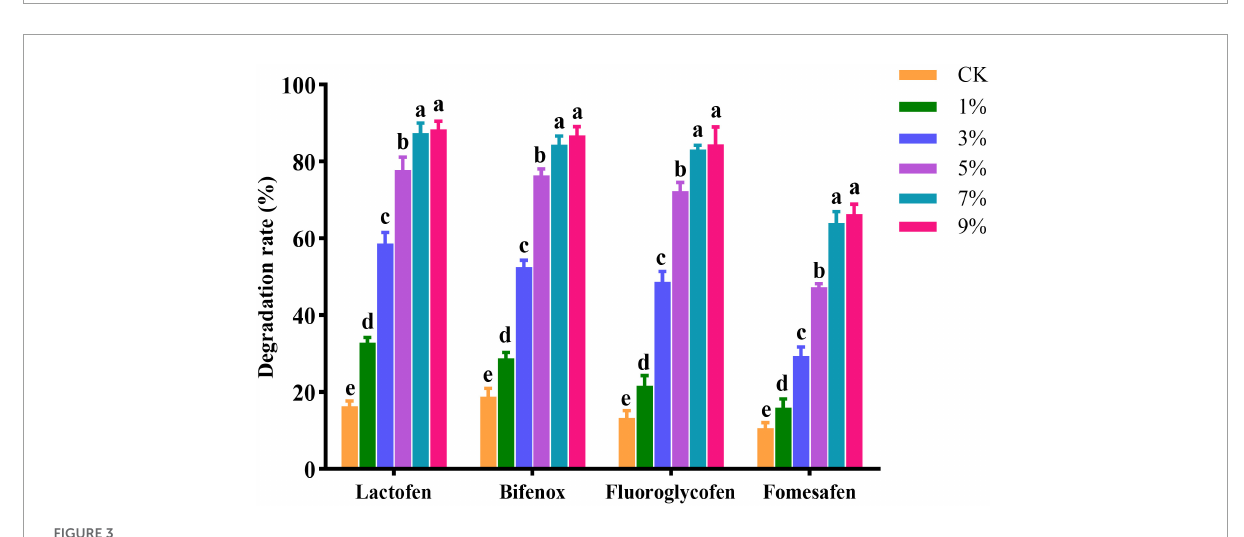
FIGURE3 Effect of application rate on degradation of diphenyl ether herbicides by solid